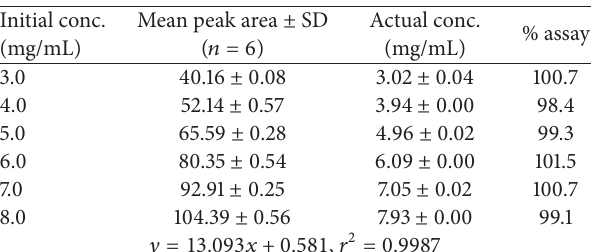
Table 1: Linearity data of the developed method.